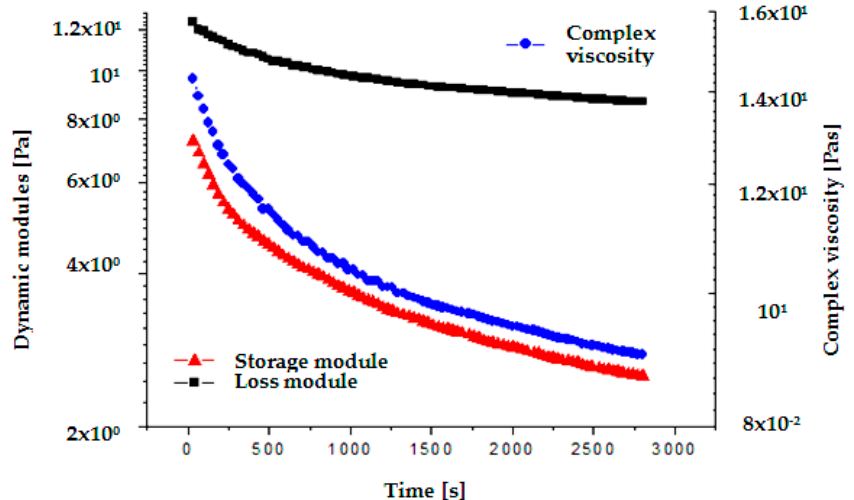
Energies 2019 , 12 , x FOR PEER REVIEW Figure 11. Storage module, loss module and complex viscosity for EM_4b. Figure 11. Storage module, loss module and complex viscosity for EM_4b.